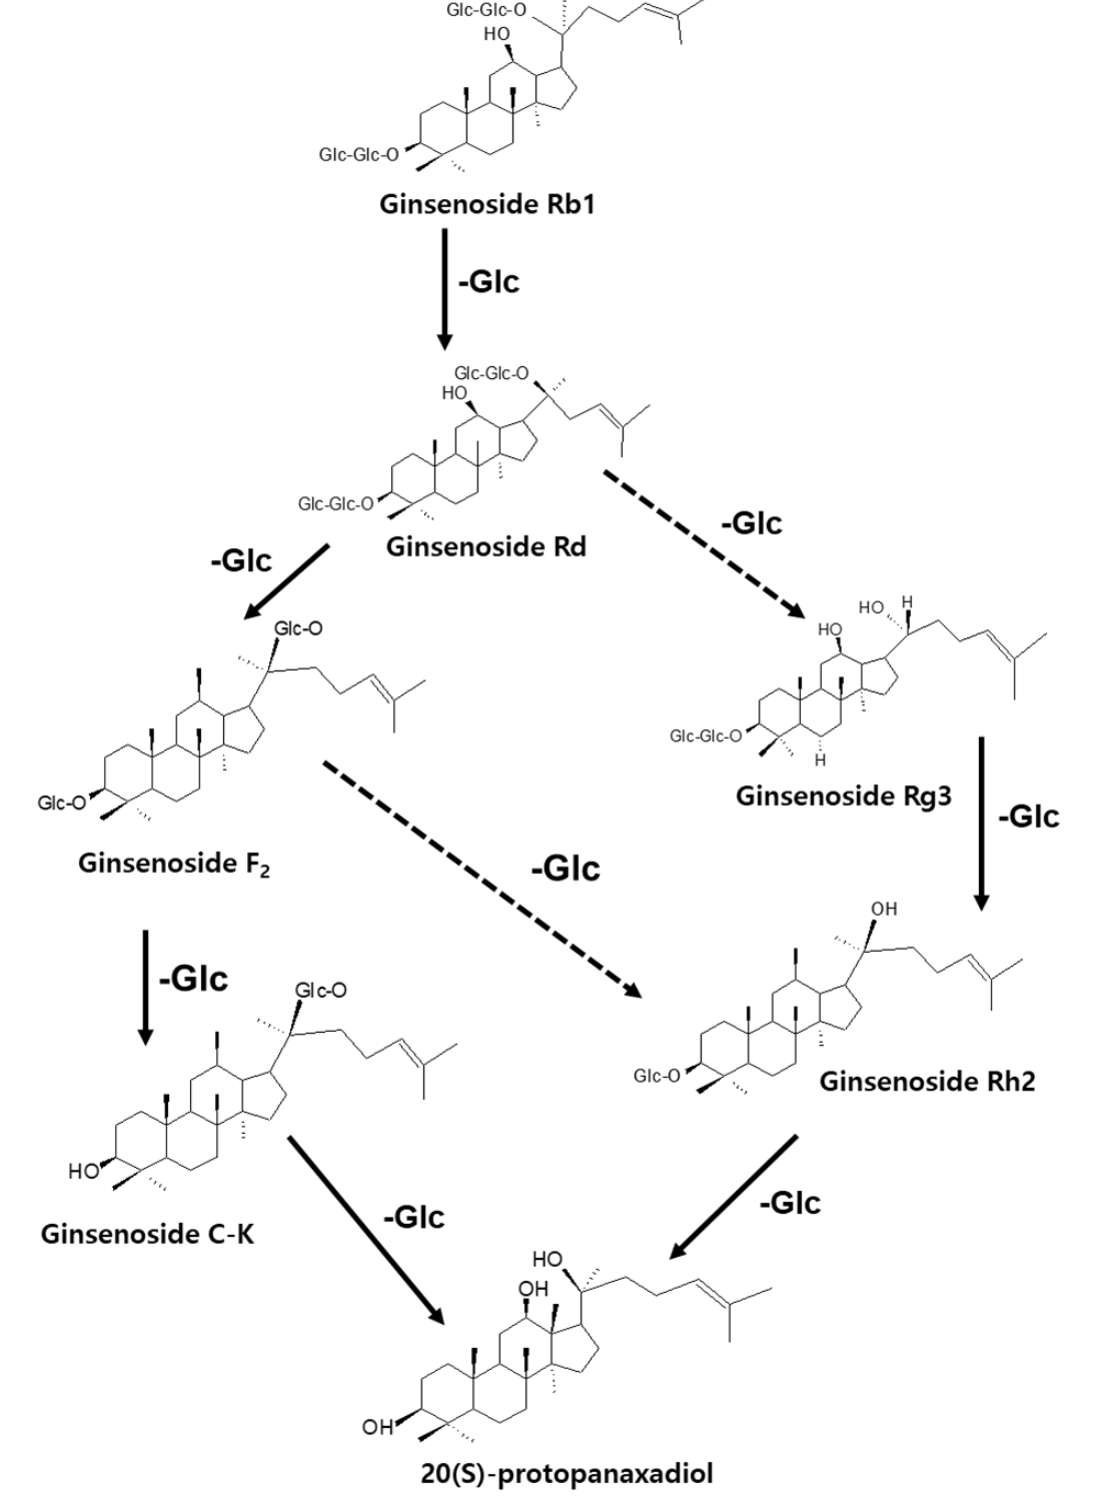
Figure 1. Production of less-polar ginsenosides by the elimination of sugar moieties.